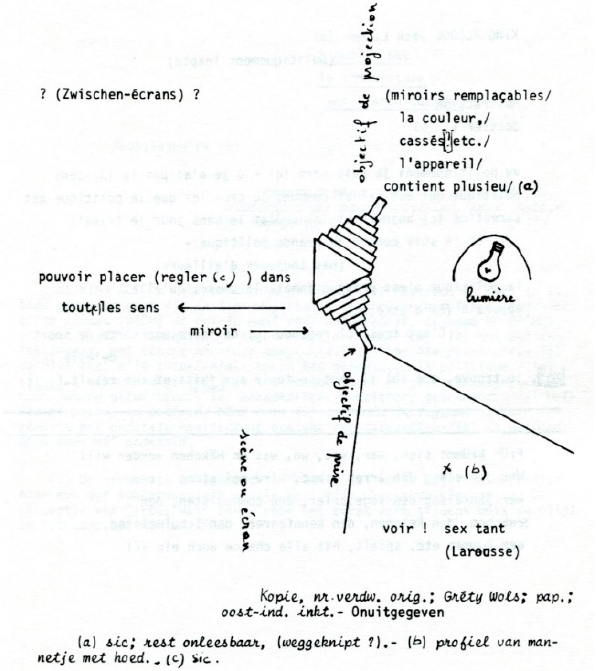
Figure 3. Wols, The Polyscope, archives Wols, folder Circus Wols. Transcription Claire van Damme, 1985. Used with permission/Courtesy Claire Van Damme.